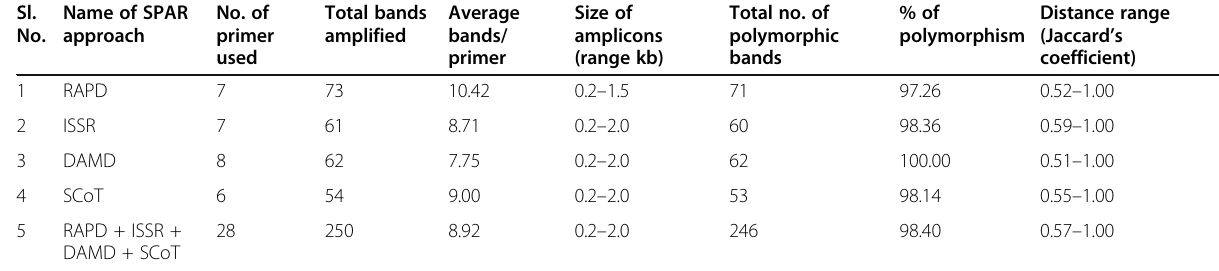
Table. 3 Individual as well as collective comparison of SPAR methods (RAPD, ISSR, DAMD and SCoT) Sl. Name of SPAR No.